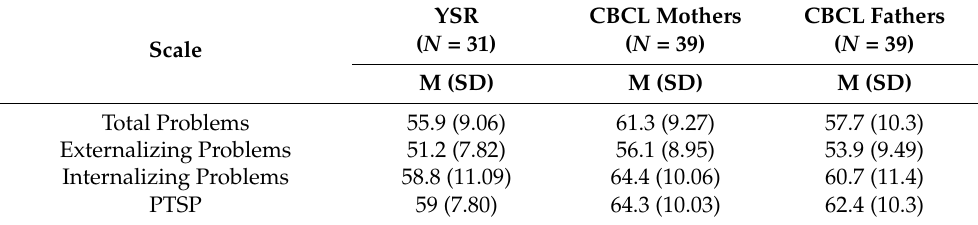
Table 5. Mean (M) and Standard Deviation (SD) values in the main YSR and CBCL scales of patients at T1.